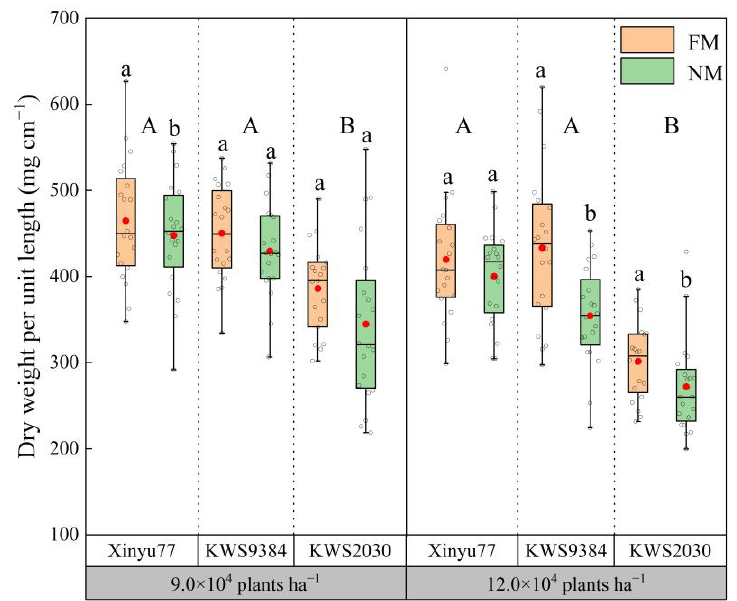
Figure 5. Differences of dry weight per unit lengths between film mulch (FM) and no-film (NM) planting under different plant densities and cultivars. The boxes represent IQRs, the whiskers indicate reasonable sample borders (Tukey tests) the horizontal line in each box indicates the median, and the solid red dot shows the mean. Different lowercase letters indicate significant differences ( p < 0.05) between the FM and NM treatments. Different capital letters indicate significant differences ( p < 0.05) among cultivars.